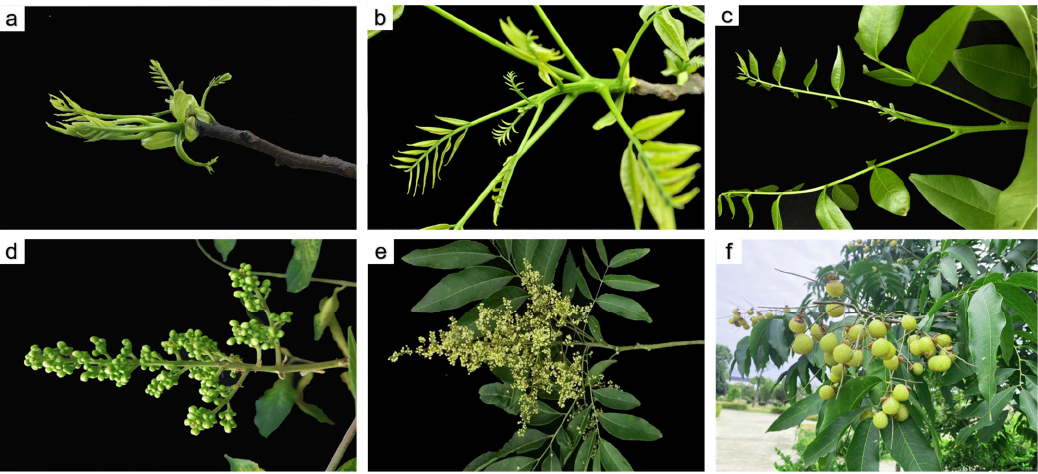
Figure 3. Developmental dynamics of bearing shoots. ( a ) bud sprouts and leaf-spreading stage; ( b ) new shoot continues to grow and develop, and the apical growth point continues to grow; ( c ) inflorescence sprouts on the top of new shoots; ( d ) inflorescence continues to grow and develop; ( e ) inflorescence flowering; ( f ) infructescence.